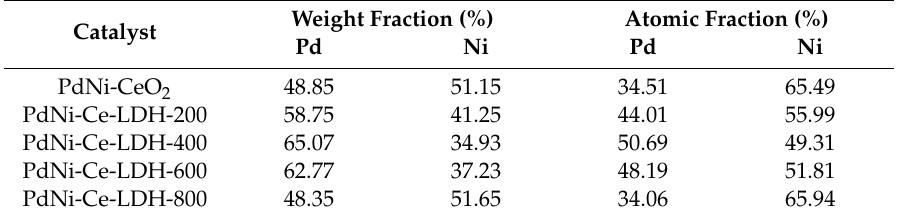
Table 4. Relative weight and atomic fraction of the loaded palladium and nickel for the di ff erent catalysts as determined by localized SEM-EDX measurements at 1000 × magnification. Weight Fraction (%) Atomic Fraction Catalyst